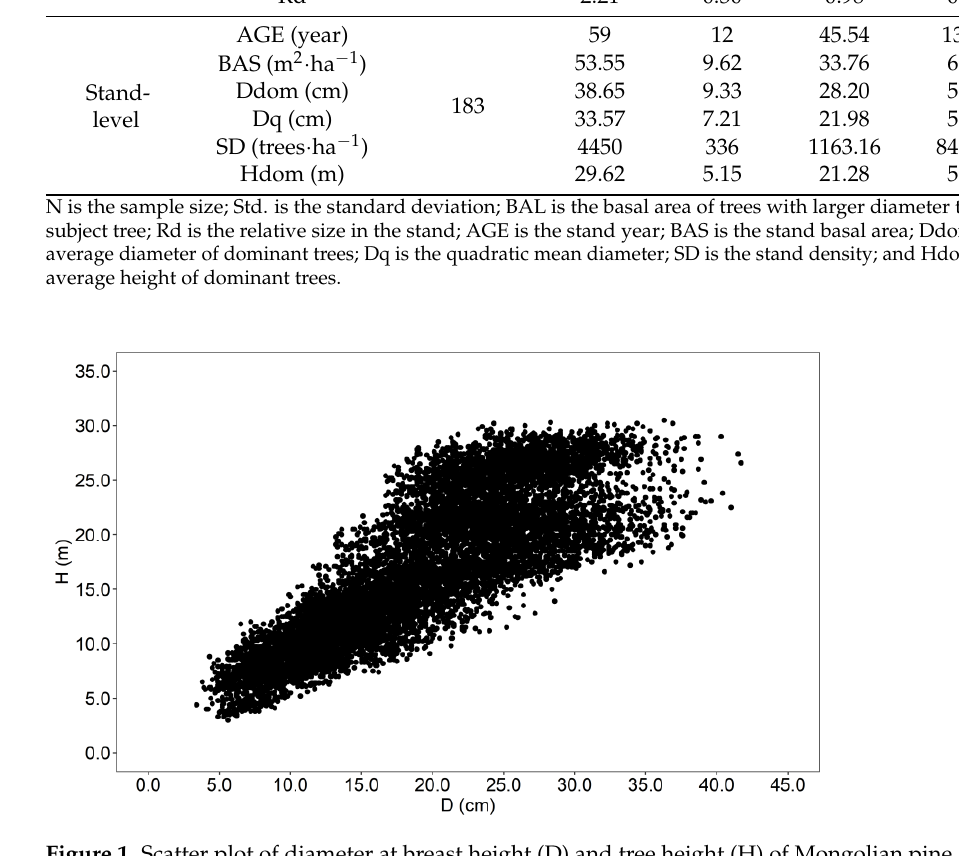
Figure 1. Scatter plot of diameter at breast height (D) and tree height (H) of Mongolian pine.